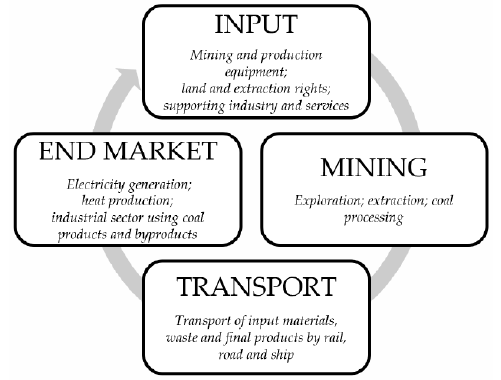
Figure 9. Representative diagram of the coal value chain.